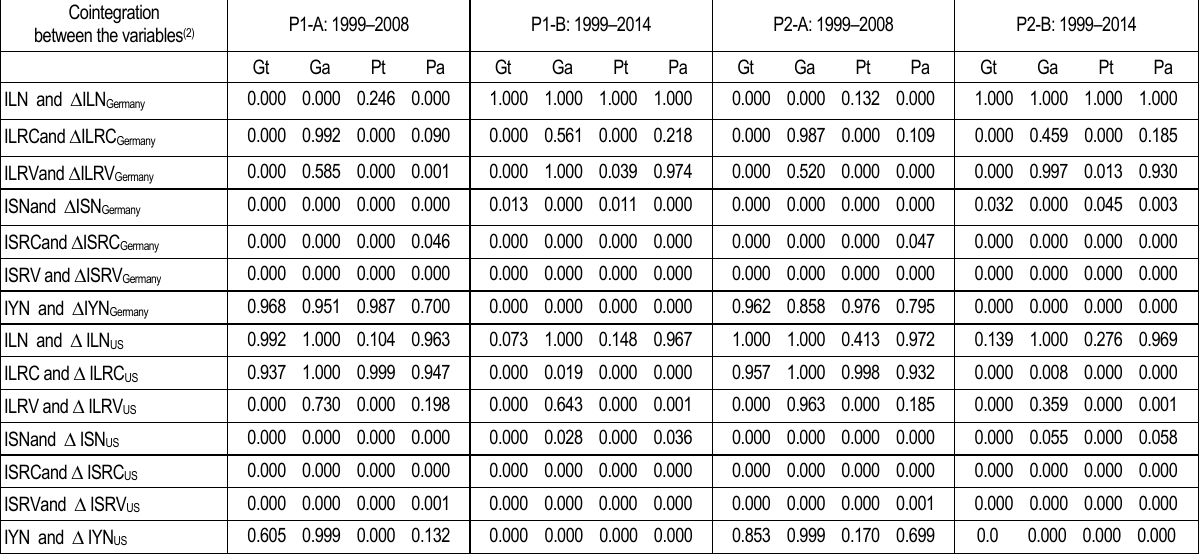
Table 3. Westerlund panel cointegration test